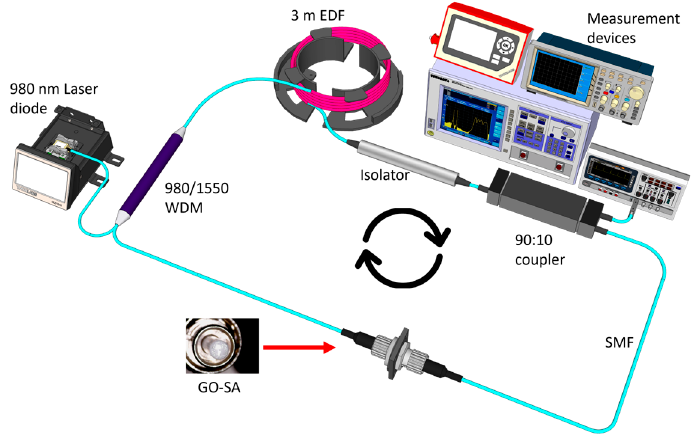
Figure 2. Configuration of the mode-locked EDFL with GO-PEO film-based SA consist of 980nm laser diode, 980/1550 nm WDM, 3 m EDF, isolator, 90:10 coupler, measurement devices, SMF and GO-SA thin film.